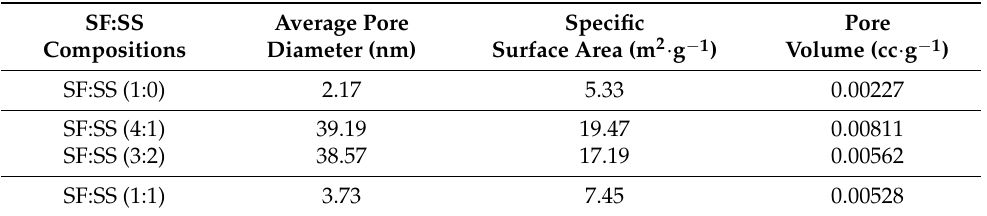
Figure 2. ( a ) N 2 adsorption-desorption isotherm and ( b ) BJH pore distribution of various SF:SS composites. Table 1. Specific surface area and pore properties of SF and composite sorbent at different SF:SS